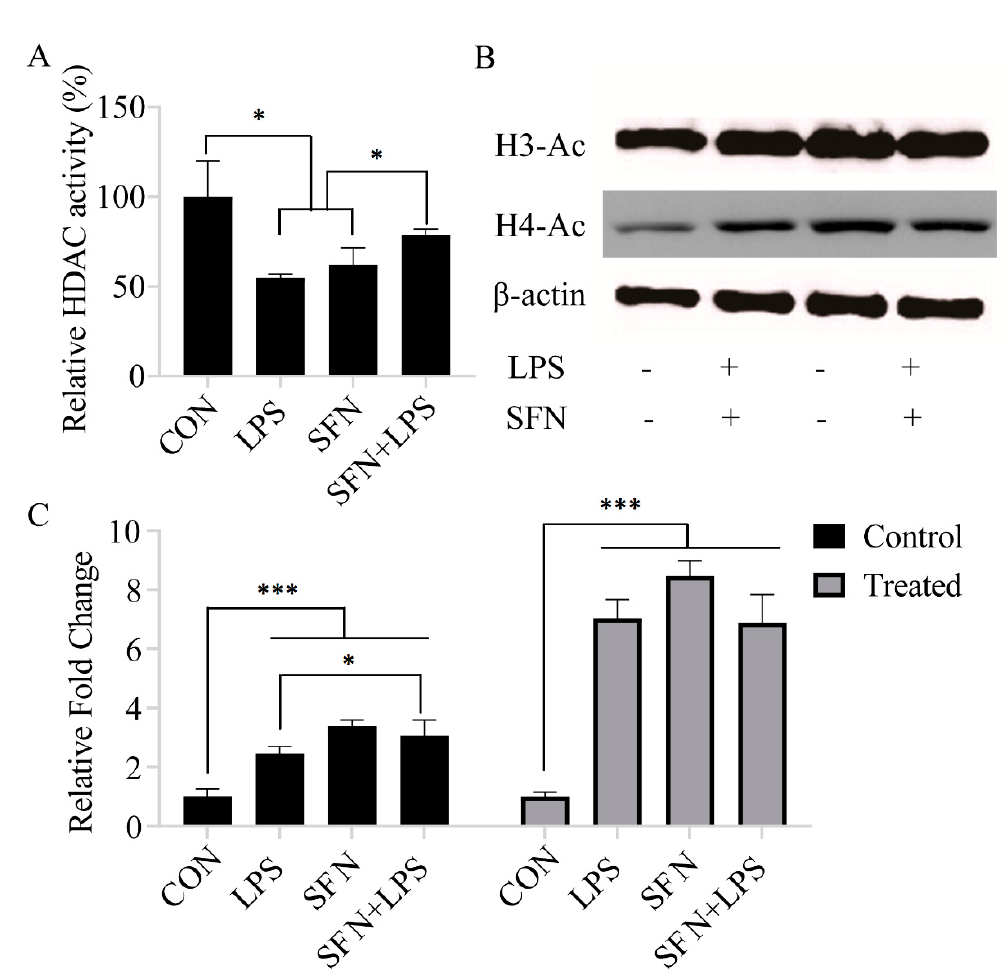
Figure 1. Sulforaphane (SFN) induced histone acetylation and inhibited histone deacetylase (HDAC) activity. The Color-de-Lys HDAC colorimetric activity assay kit was used for global HDAC activity determination. Monocyte-derived dendritic cells (moDCs), cultured for 7 days, were stimulated with lipopolysaccharide (LPS) (1 µ g/mL) for 24 h with or without SFN pre-incubation (10 µ M) for 24 h ( A ). The results are represented as the mean ± standard deviation (SD) of three independent experiments, and each experiment was performed in duplicate (* p < 0.05). The histone acetylation of acetylated H3 and acetylated H4 was measured by Western blotting ( B ). The Western blotting results are from one of three independent experiments. The original image can be found in Supplementary file. Quantifications of the immunoblots of acetylated H3 and acetylated H4 are from three independent experiments (* p < 0.05; ** p < 0.01; *** p < 0.001) ( C ).